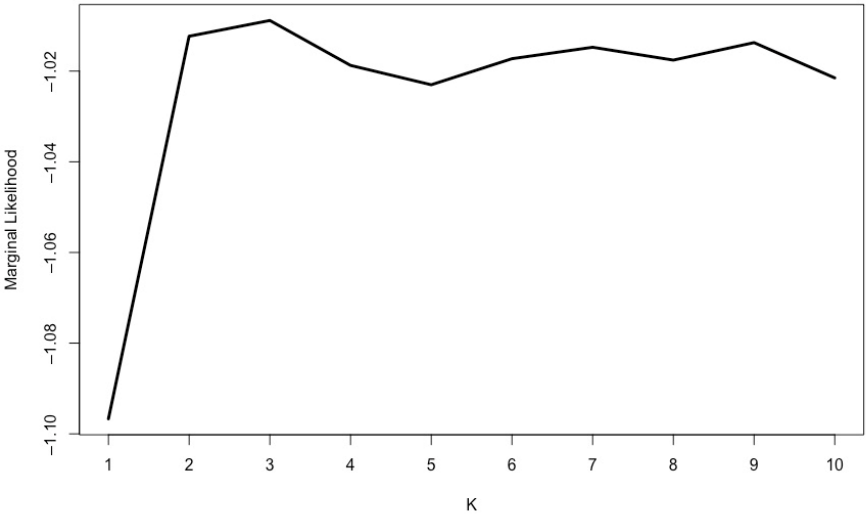
Figure 2. The most likely K clusters obtained in fastStructure.